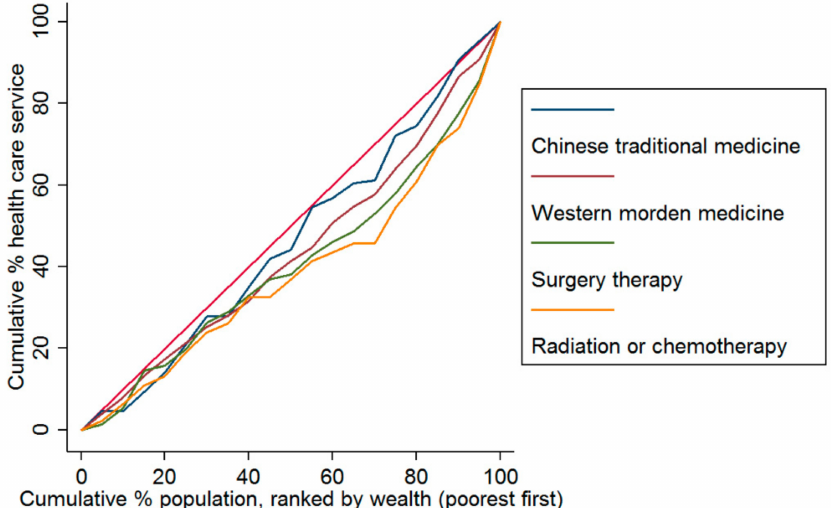
Figure 1. Concentration curves of treatments for patients with cancer in China in 2015.